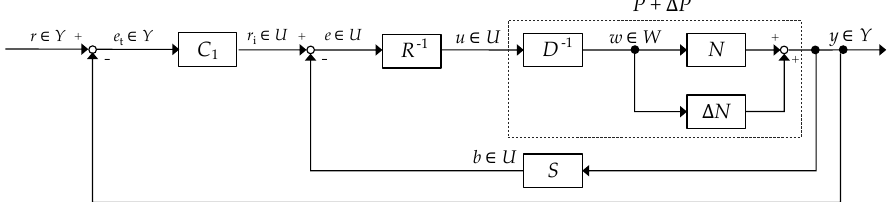
Figure 5. Block diagram of calorimetric system.